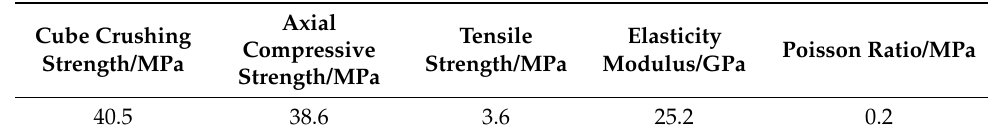
Table 6. Mechanical properties of concrete.